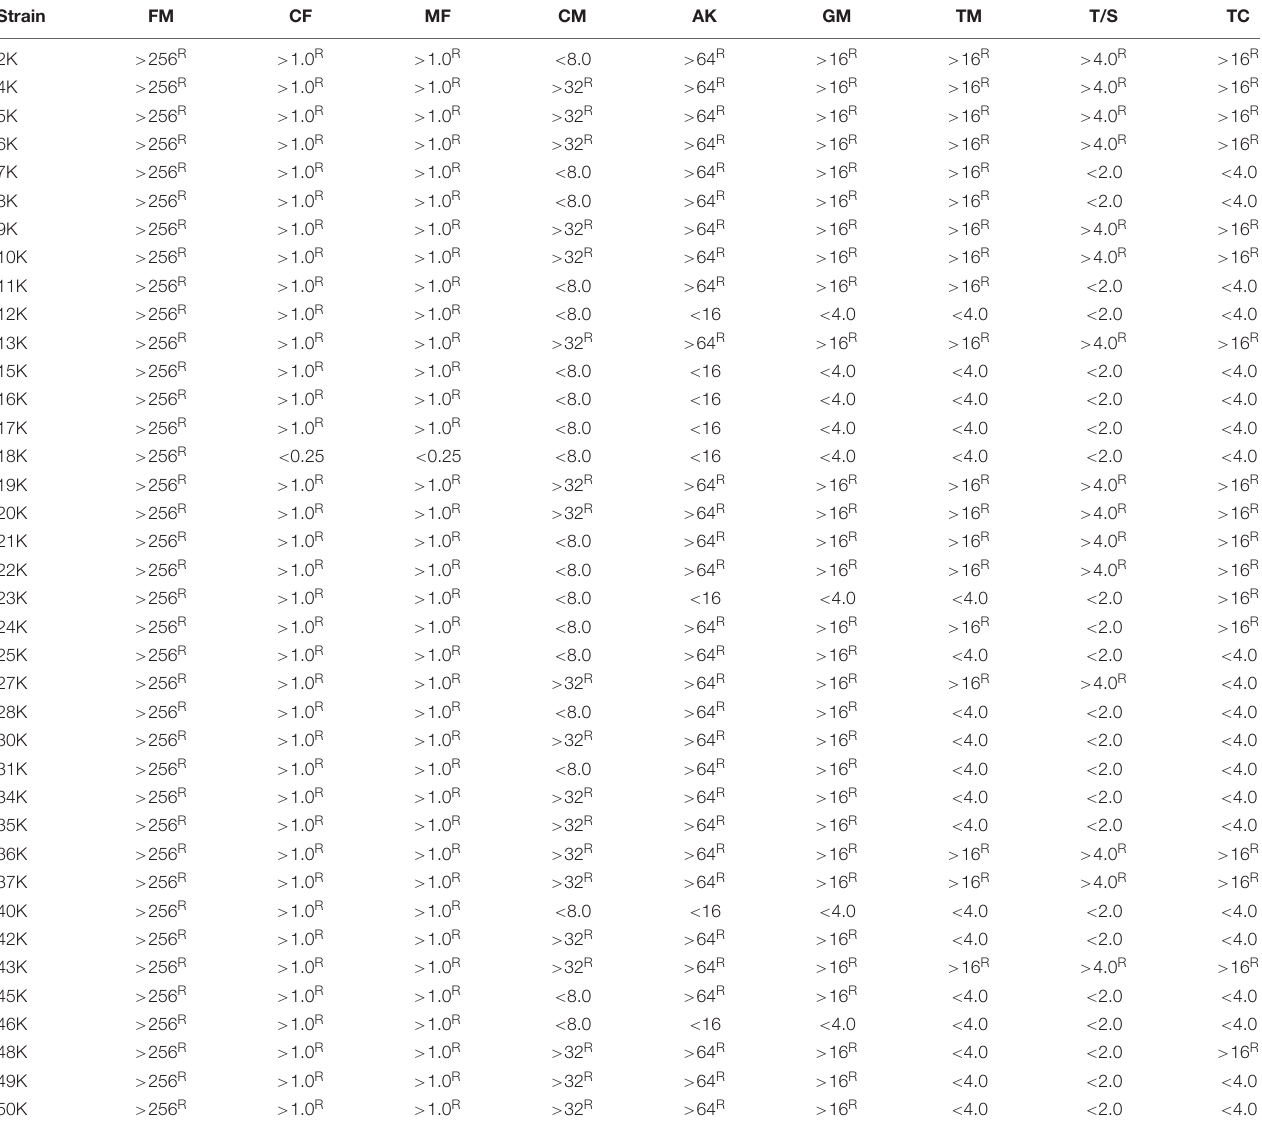
TABLE 6 | MIC ( µ g/mL) of the 38 clinical isolates of K. pneumoniae according to CLSI. Strain